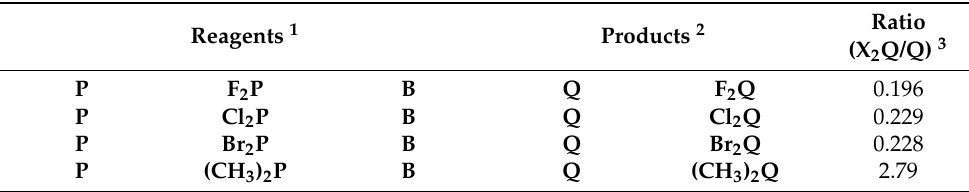
Table 2. Ratio of 2,3-diphenylquinoxaline and 6,7-disubstituted-2,3-diphenylquinoxaline formed in competition experiments in the